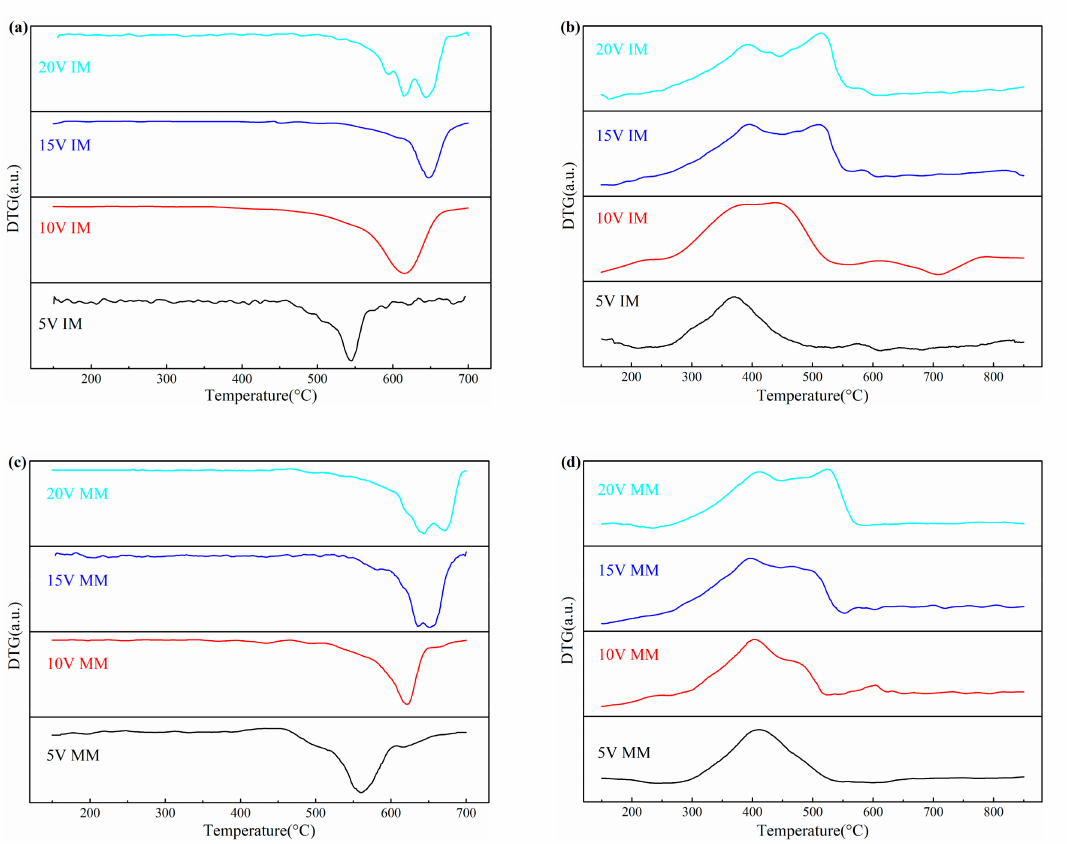
Figure 3. H 2 -TPR and O 2 -TPO profiles for V-based oxygen carriers with different V loadings: ( a ) H 2 -TPR for impregnation method, ( b ) O 2 -TPO for impregnation method, ( c ) H 2 -TPR for mechanical mixing method, ( d ) O 2 -TPO for mechanical mixing